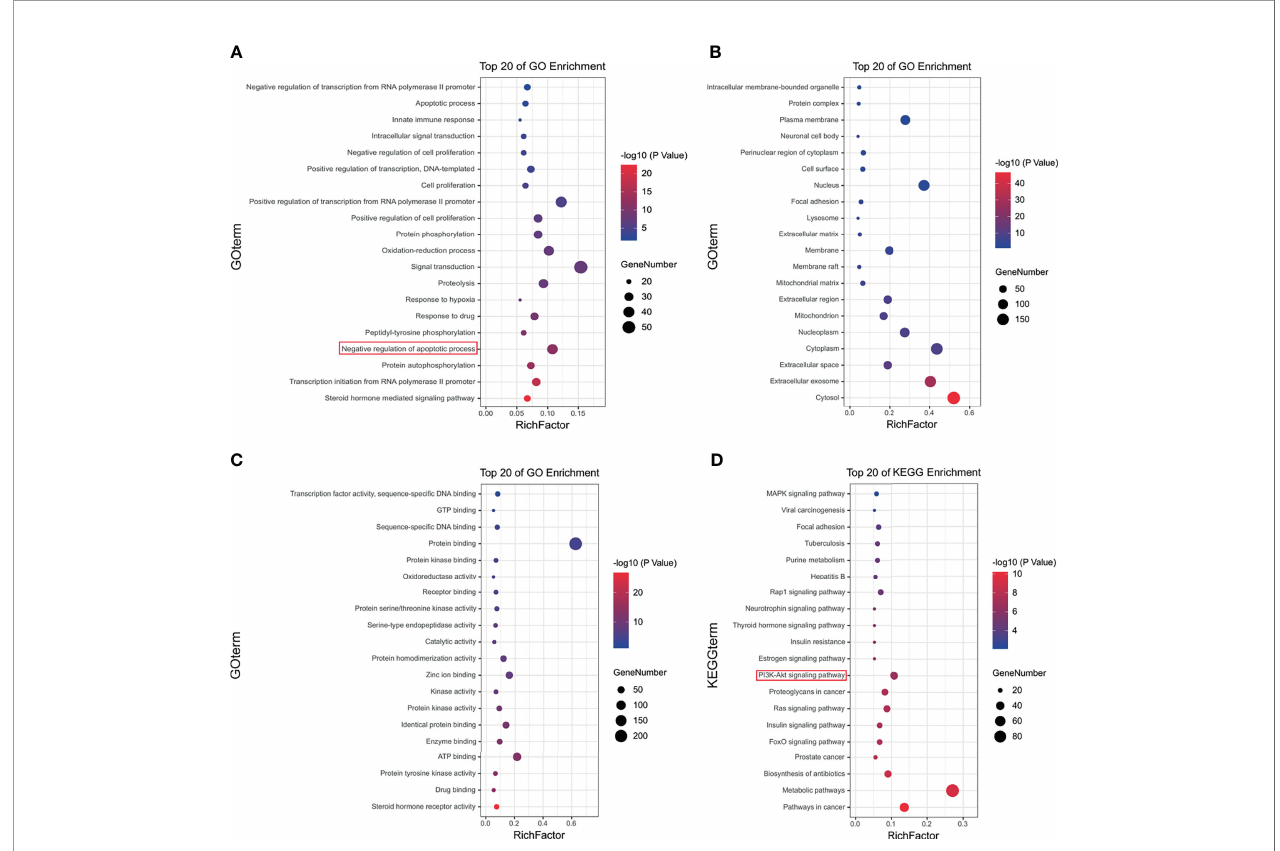
FIGURE 3 | Gene Ontology (GO) and Kyoto Encyclopedia of Genes and Genomes (KEGG) pathway analyses of HF. Top 20 signaling pathways of HF in (A) GO-BP pathway analysis, (B) GO-CC pathway analysis, and (C) GO-MF pathway analysis. (D) Top 20 signaling pathways of HF in KEGG enrichment pathway